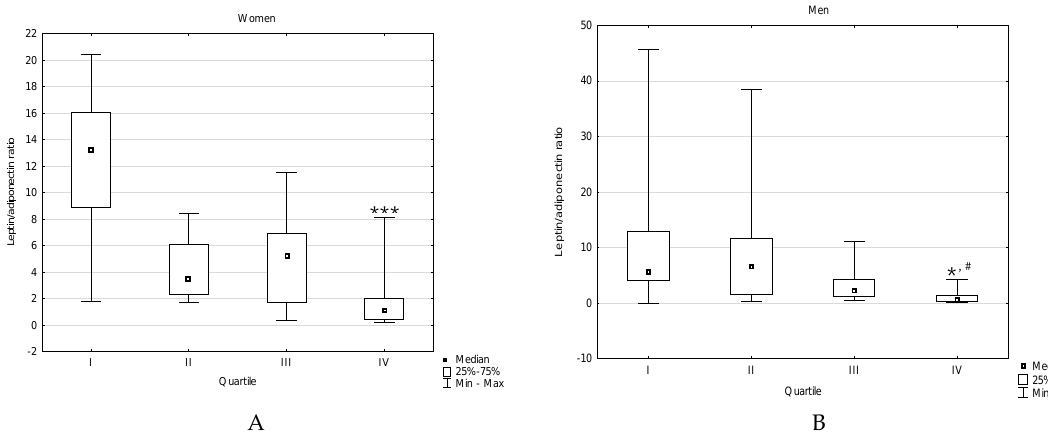
Figure 2. Leptin/adiponectin ratio in type 2 diabetic women ( A ) and men ( B ) divided according to plasma 25(OH)D 3 level. * p < 0.05 vs. quartile I, *** p < 0.001 vs. quartile I, # p < 0.05 vs. quartile II .